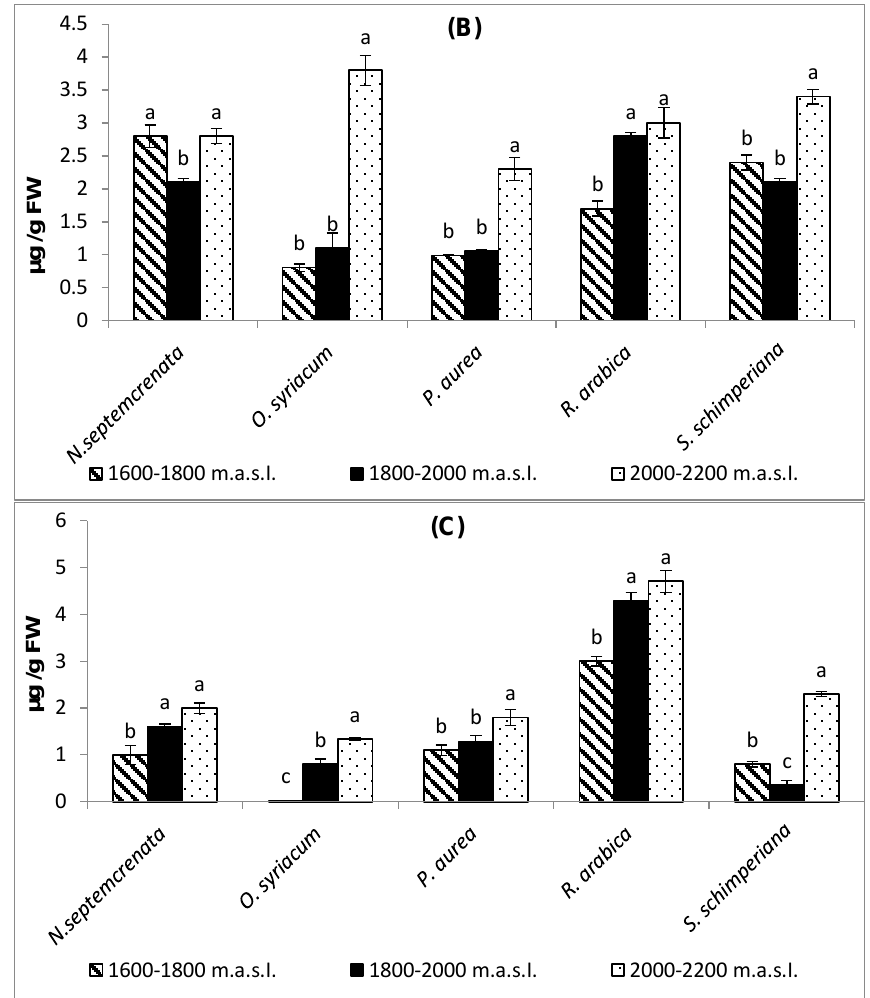
Figure 1. Effect of altitude on the photosynthetic pigments chlorophyll a ( A ), chlorophyll b ( B ), and carotenoids ( C ). Each value is the mean of three replicates ± SE. Bars with different letters are significantly different at p ≤ 0.05.